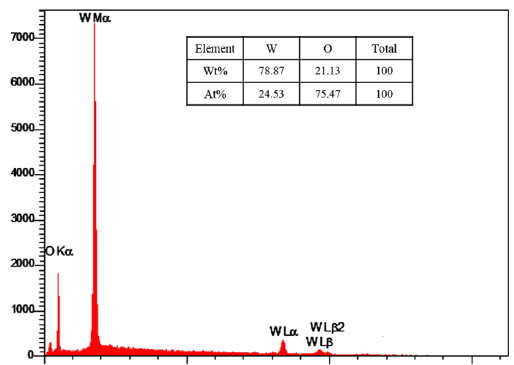
Figure 4. EDS spectrum of the nano powder prepared by the addition of 262 mmol oxalic acid and 8.25 mmol PEG to the gel and heating at 550 ºC for 90